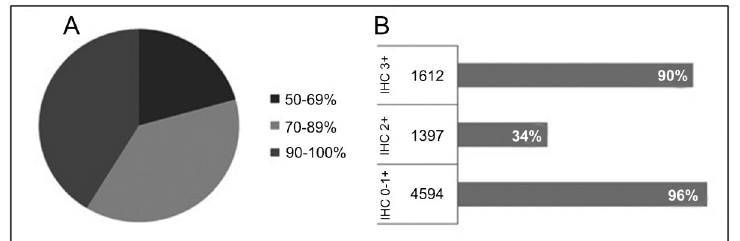
Figure 1. Forty-seven studies (14-18,23- 30,32,34-55,57-65,67,68) comparing CISH to IHC methodology for breast cancer samples. A , Agreement between the two methodologies ranging from 50 to 100%. B , Percent agreement based on IHC subgroups (0-1 + , 2 + and 3 + ) compared to amplified and non-amplified HER2 status by CISH. CISH = chromogenic in situ hybridization; IHC =